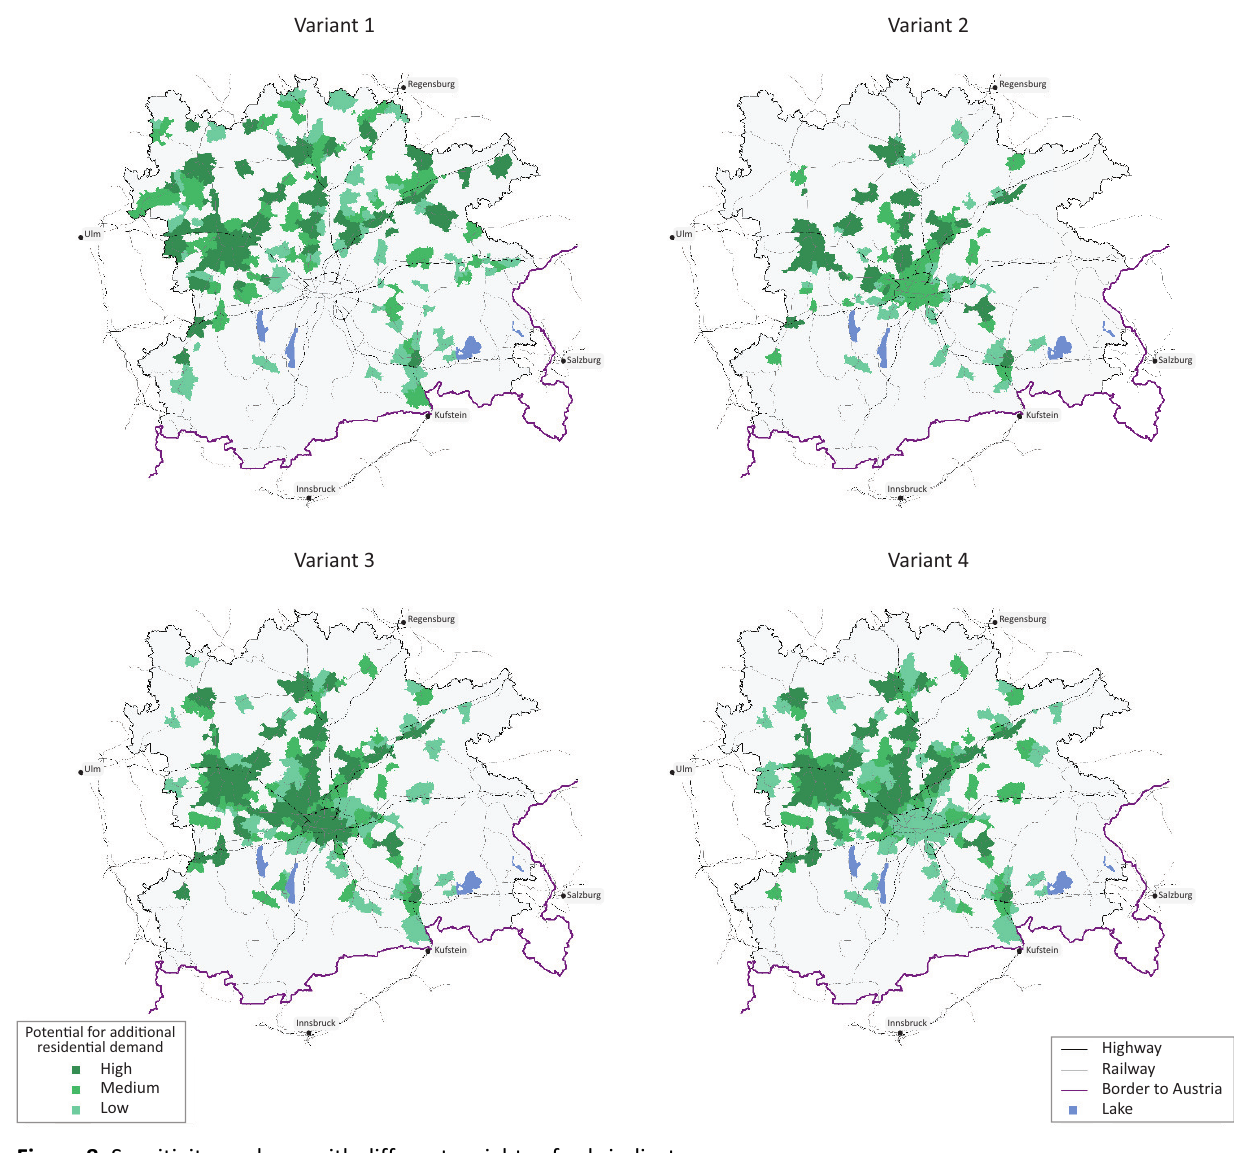
Figure 8. Sensitivity analyses with different weights of sub‐indicators. While urban agglomerations have introduced high‐speed broadband, many rural areas did not do so at a com‐ parable pace. Therefore, Germany is still characterised by a high regional variation in broadband availability (Gürtzgen et al.,